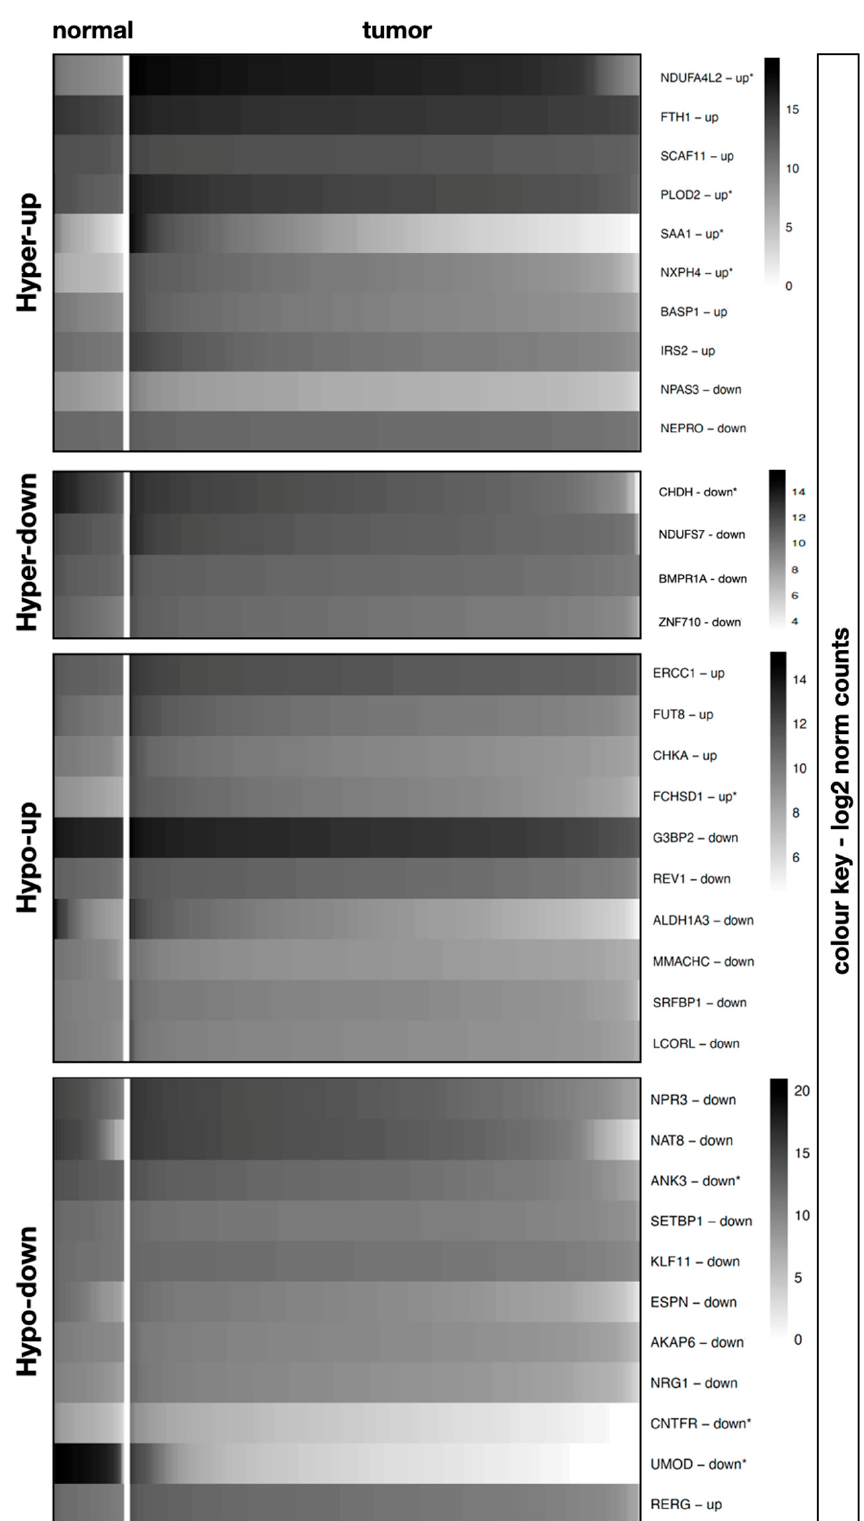
Figure 1. Heatmap based on TCGA-KIRC cohort expression data. The “hyper-up”, “hyper-down”, “hypo-up”, and “hypo-down” groups were defined by Chen et al. (21) and based on potential m6A-driven expression patterns. Genes were hierarchically clustered and samples were subsequently arranged based on gene expression. * Indicates that the TCGA mRNA dysregulation pattern matched the pattern described by Chen and meets significance criteria ( p -value < 0.05 and FC > 2 or < 0.5).